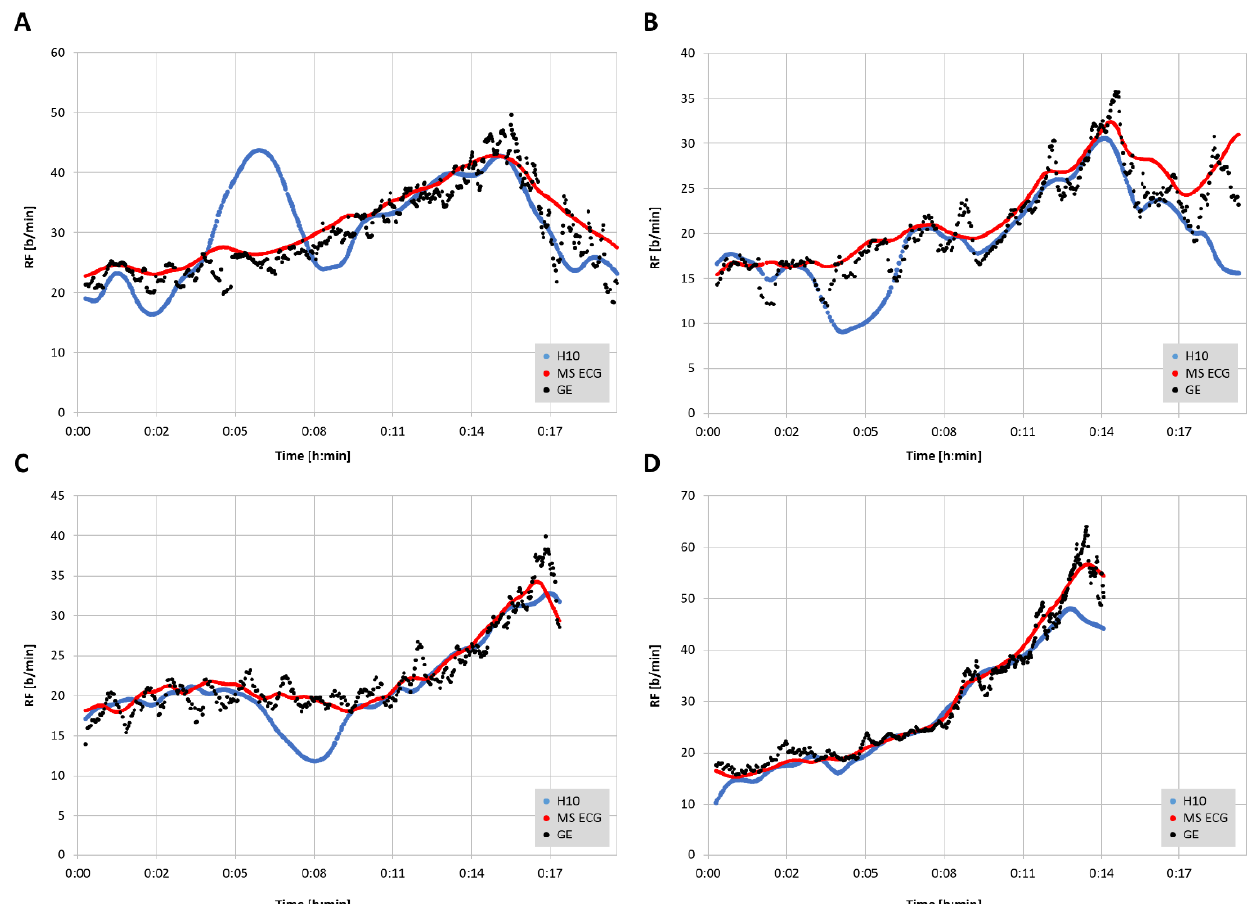
Figure 3. Respiratory frequency (RF) plotted over time for Movesense Medical sensor ECG (MS ECG), Polar H10 (H10) (Kubios window width: 30 s, grid interval: 1 s) and the gas exchange data (GE) in four representative participants. ( A ): 26-year-old female with a BMI of 30 kg/m², VO 2MAX of 38 mL/kg/min, Kubios artifact rate of 0.5%; ( B ): 27-year-old female with a BMI of 22 kg/m², VO 2MAX of 42 mL/kg/min, Kubios artifact rate of 0.0%; ( C ): 47-year-old male with a BMI of 38 kg/m², VO 2MAX of 31 mL/kg/min, Kubios artifact rate of 0.0%; ( D ): 25-year-old female with a BMI of 21 kg/m², VO 2MAX of 40 mL/kg/min, Kubios HRV artifact rate of 0.7%. MS ECG (red circle), H10 (blue circle), GE (black). Ramp termination corresponds with peak GE respiratory rate. Length of post ramp recovery determined by data recording cessation and artifacts below 3%.